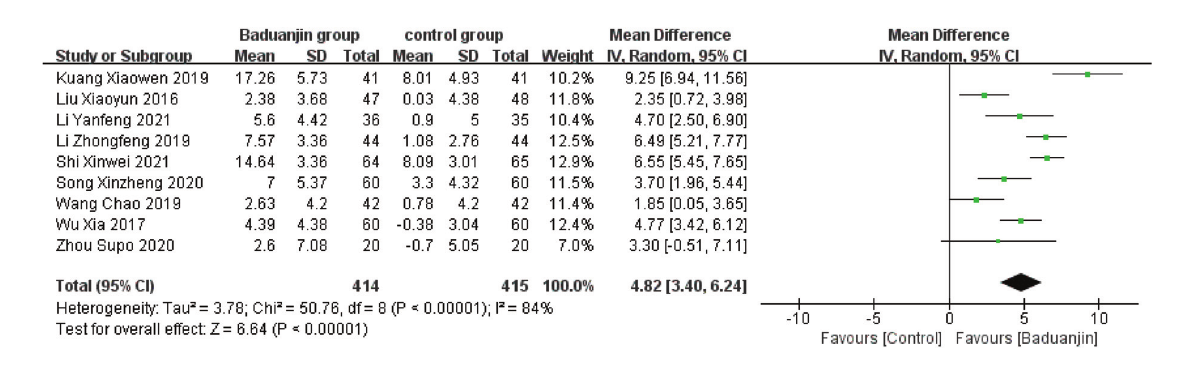
P < 0.000 1; LE: MD = − 2.66, 95% CI ( − 3.12, − 2.20), P < 0.000 01] and ECLSB [ME: MD = 2.32, 95% CI (1.54, 3.10), P < 0.000 1; LE: MD = 2.51, 95% CI (2.06, − 2.97), P < 0.000 01]. For